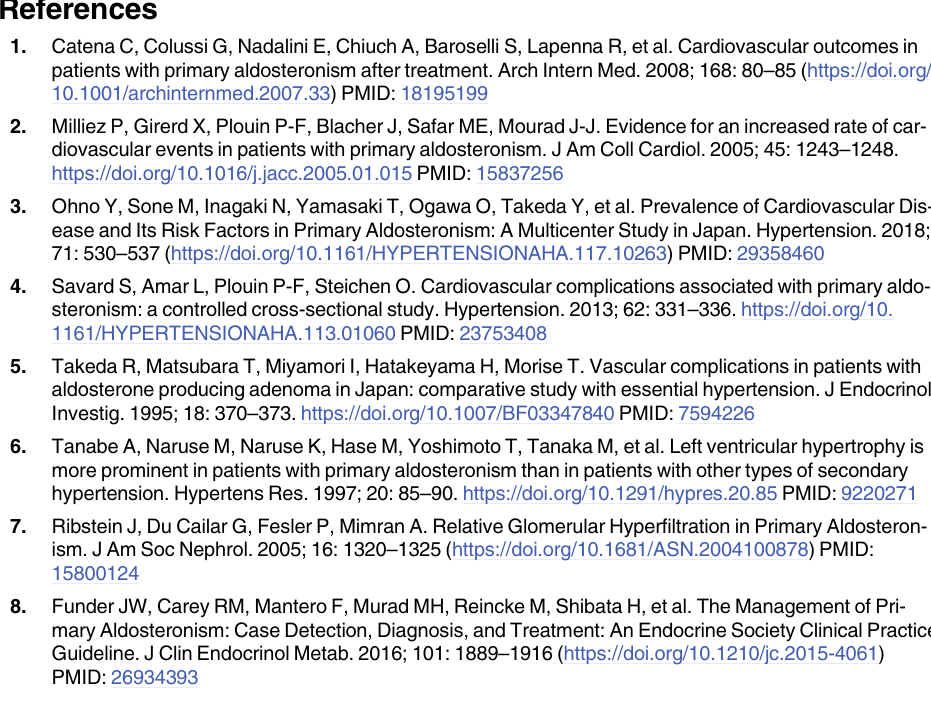
S15 Table. Detecting unilateral primary aldosteronism with Accuraseed 1 immunoanaly- zer-based aldosterone-to-renin